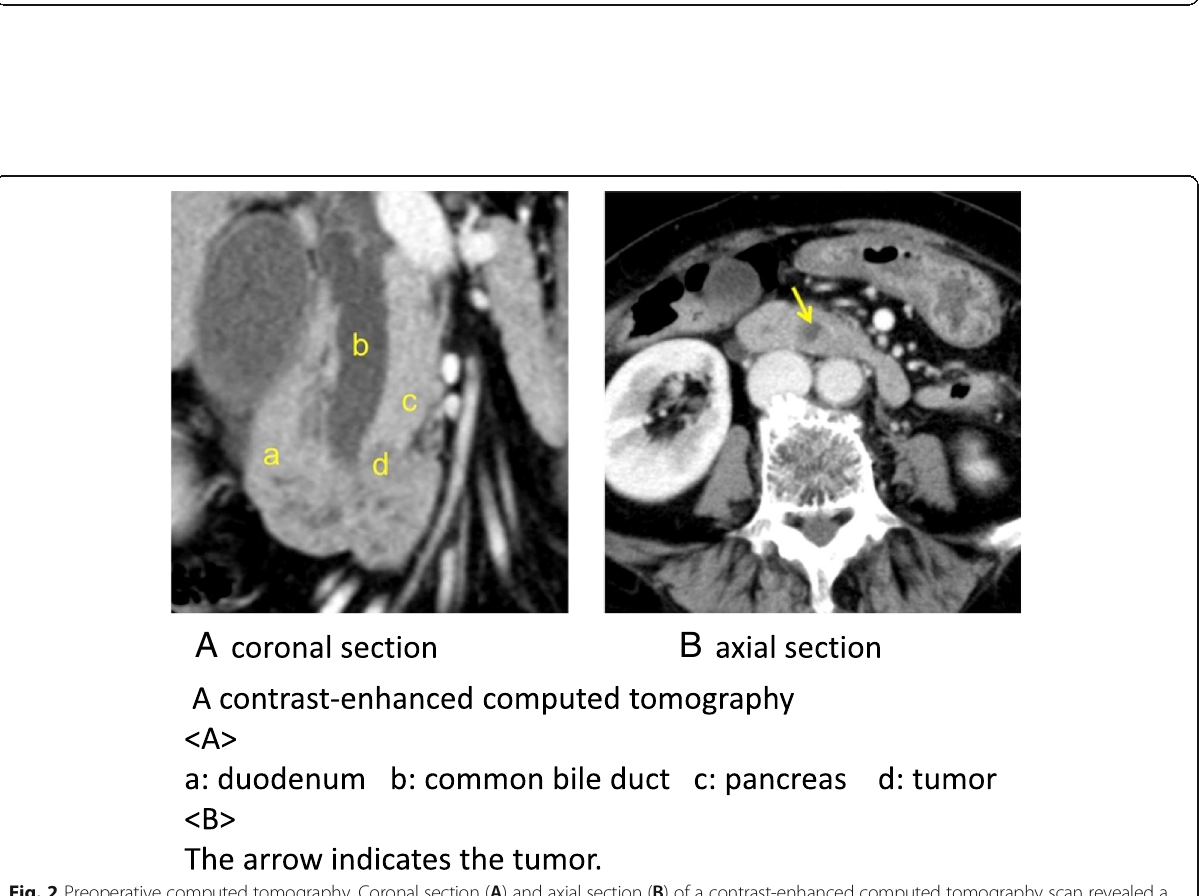
Fig. 1 Preoperative endoscopy. Endoscopy revealed a 10-mm tumor in Vater ’ s papilla and endoscopic retrograde biliary drainage was placed ( A ). Endoscopic ultrasonography revealed that the tumor (arrows) invaded pancreatic parenchyma ( B ). a, common bile duct; b, main pancreatic duct; c, duodenum